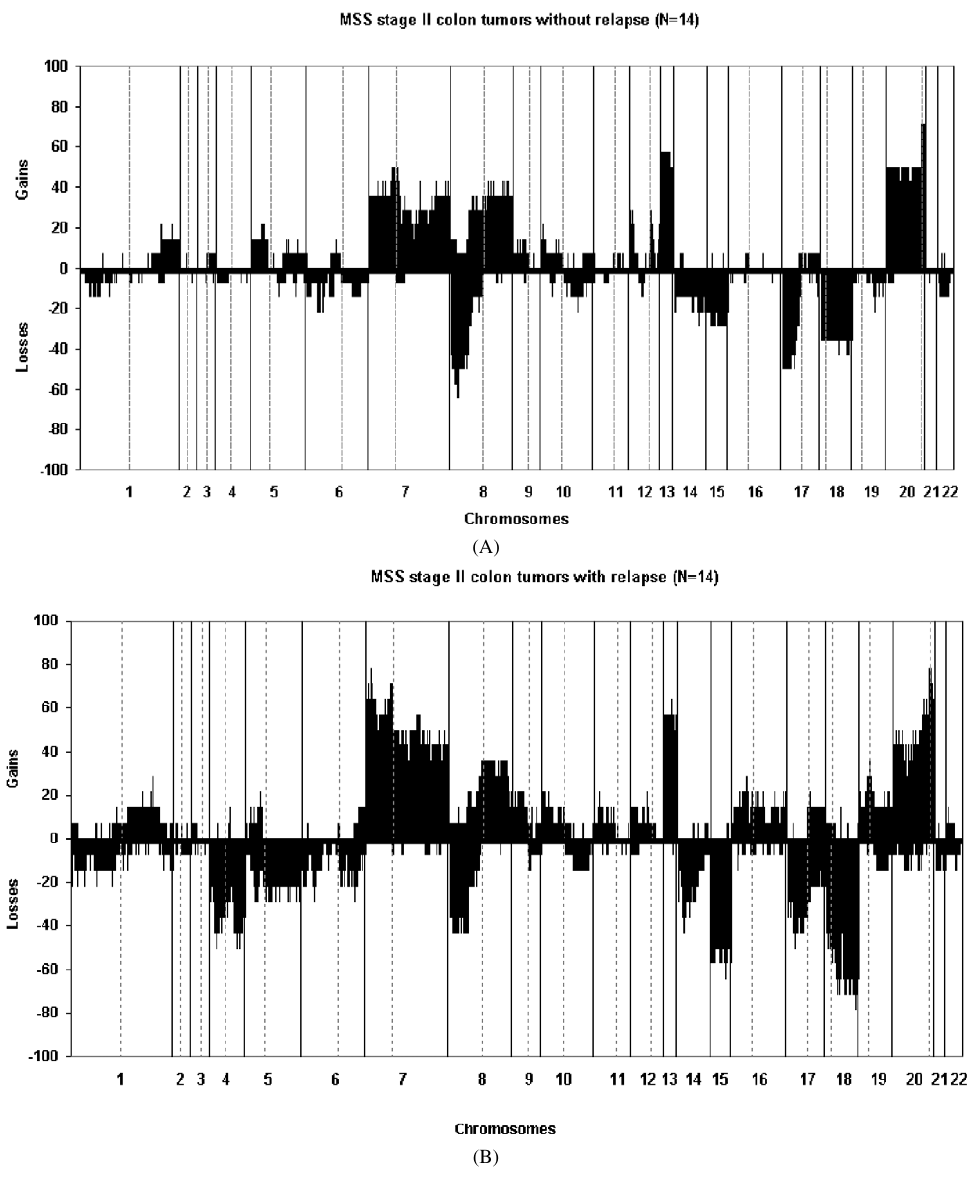
Fig. 3. Percentage of chromosomal gains and losses measured by array CGH in 28 MSS stage II colon cancer patients without (A) and with (B) relapse of disease. X -axis displays 44,000 oligo-nucleotides in genomic order (chromosomes 1–22). Y -axis displays percentage of tumor with gains ( > 0) or losses ( < 0). Boundaries of chromosomes are indicated by black vertical lines and the location of centromeres are indicated by dotted